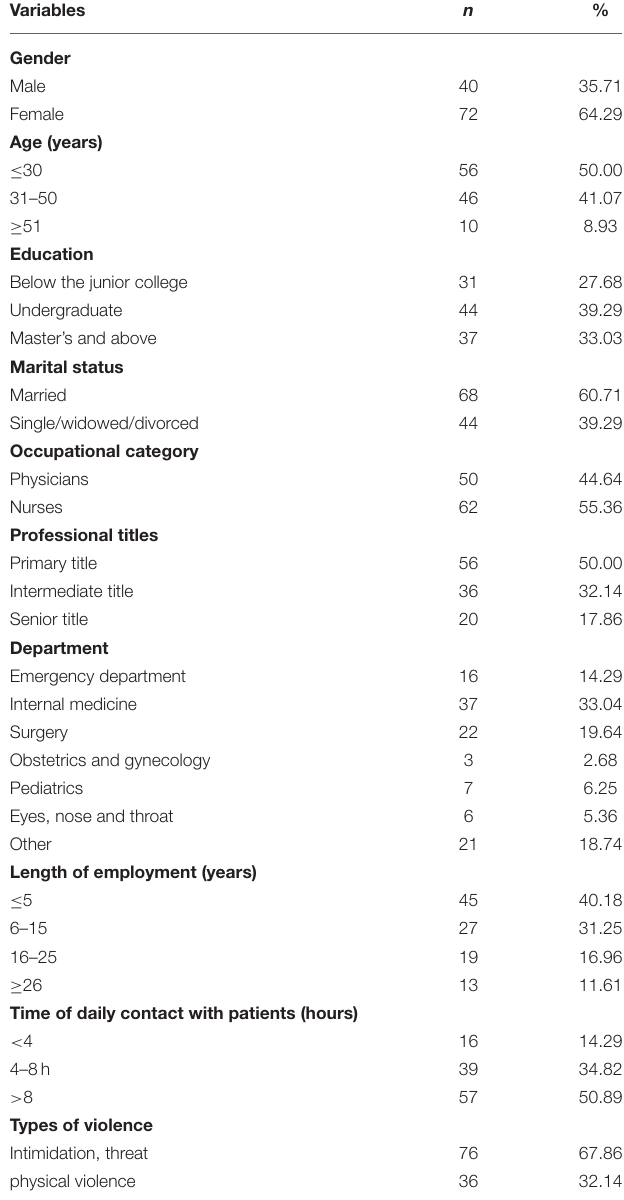
TABLE 1 | Demographic characteristics of the